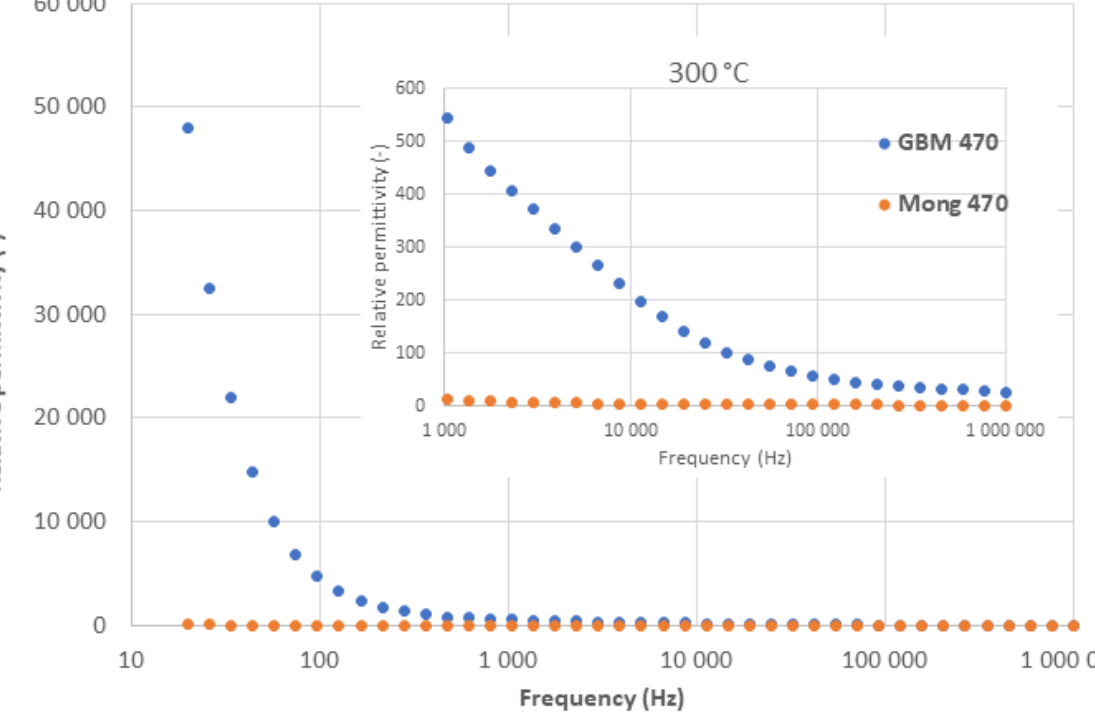
Figure 13. Relative permittivity dependence on frequency at 300 °C for coatings sprayed with SD 370.